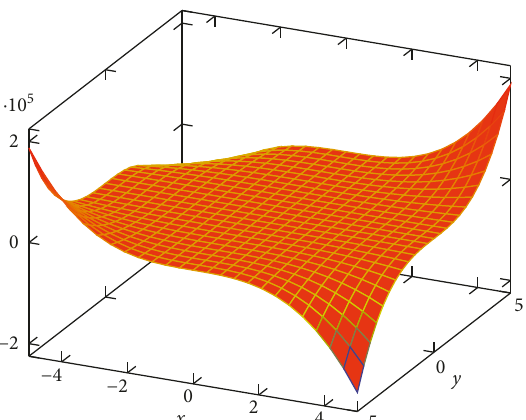
Figure 1: The toroidal polyhex.